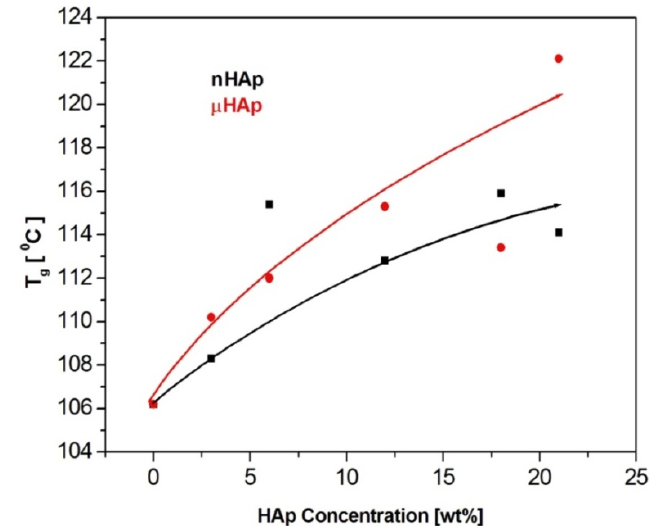
Figure 6. DSC thermograms of the pure polymer matrix and those of the composite materials containing hydroxyapatite filler at different particle size and concentrations.